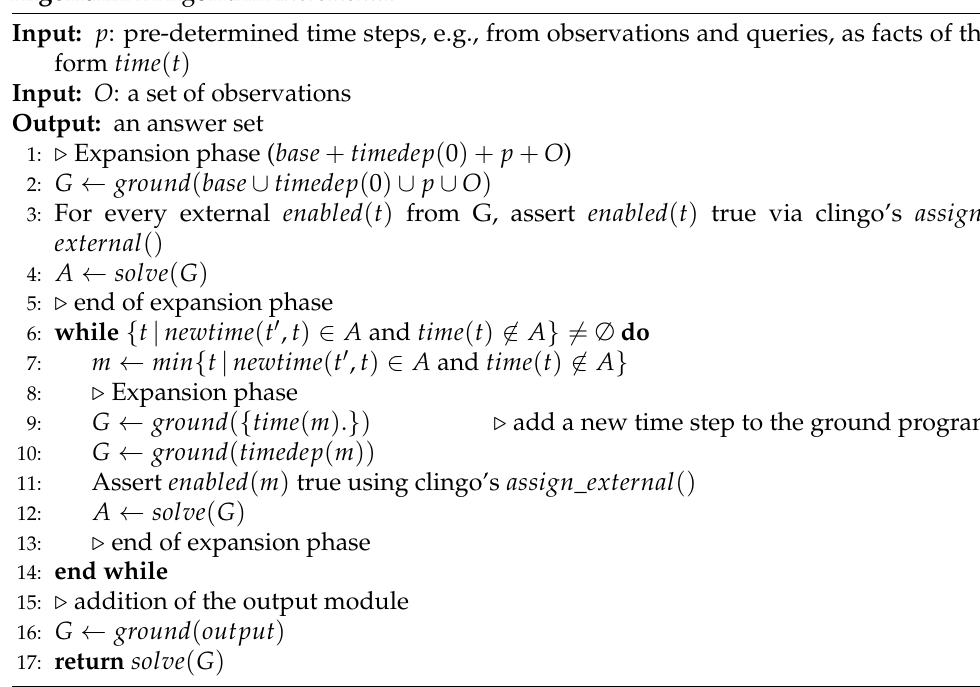
Figure 1. Graphical depiction of the steps of Incremental. Algorithm 2 Algorithm